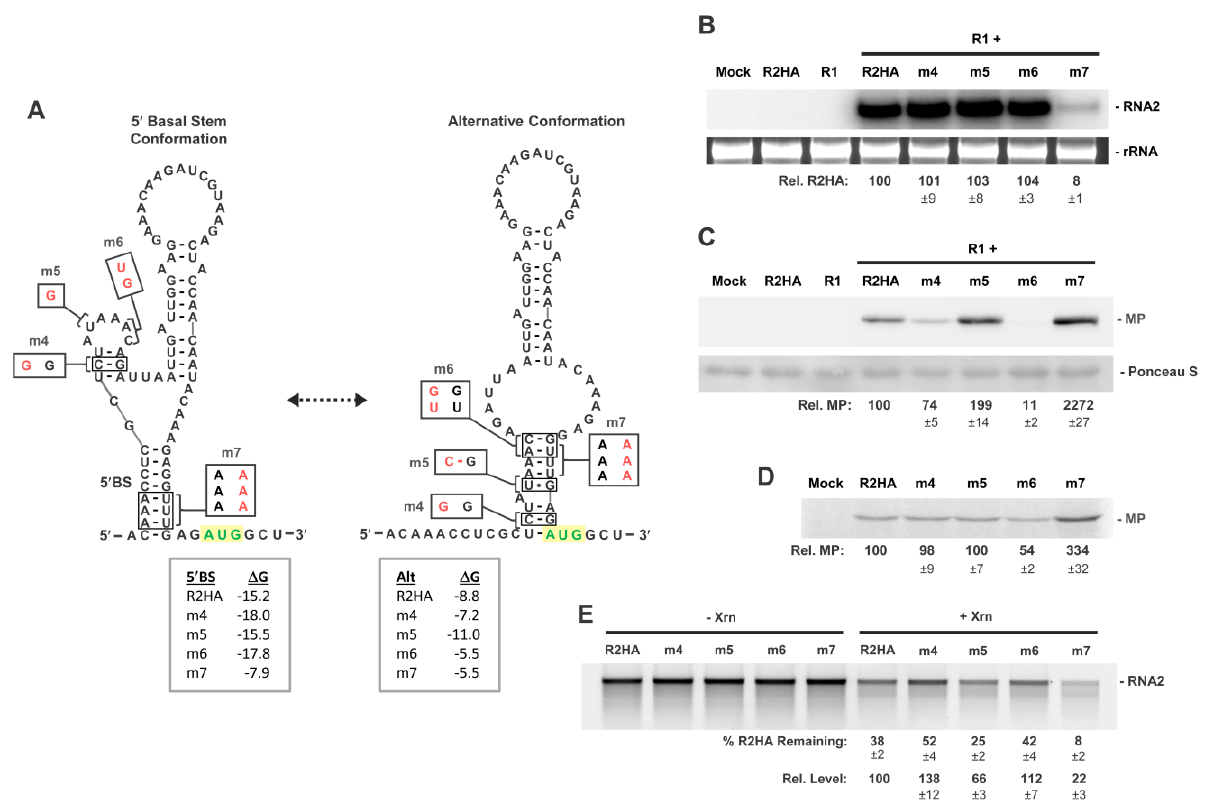
Figure 5. RNA2 5 ′ UTR mutants shifting conformational equilibrium. ( A ) RNA secondary structures for the two proposed conformations in the 5 ′ UTR of RNA2. Substitutions designed to shift the equilibrium of the two conformations are shown in red on both conformations, with predicted free energy values below. ( B ) Northern blot analysis of protoplast infections of wt RNA1 (R1) and RNA2 mutants. ( C ) Corresponding Western blot analysis of protoplast infections depicted in panel ( B ). ( D ) In vitro translation in wheat germ lysate of R2HA and mutants. ( E ) In vitro Xrn1 treatment of R2HA and mutants. Values generated as described in legend of Figure 3.